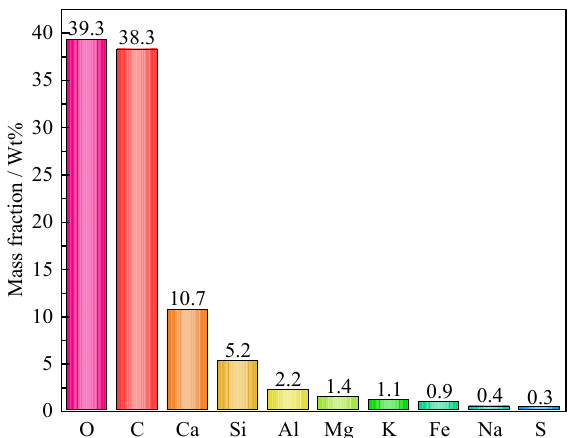
Figure 14. EDS values for hydrated products of FRCTWRF sample.